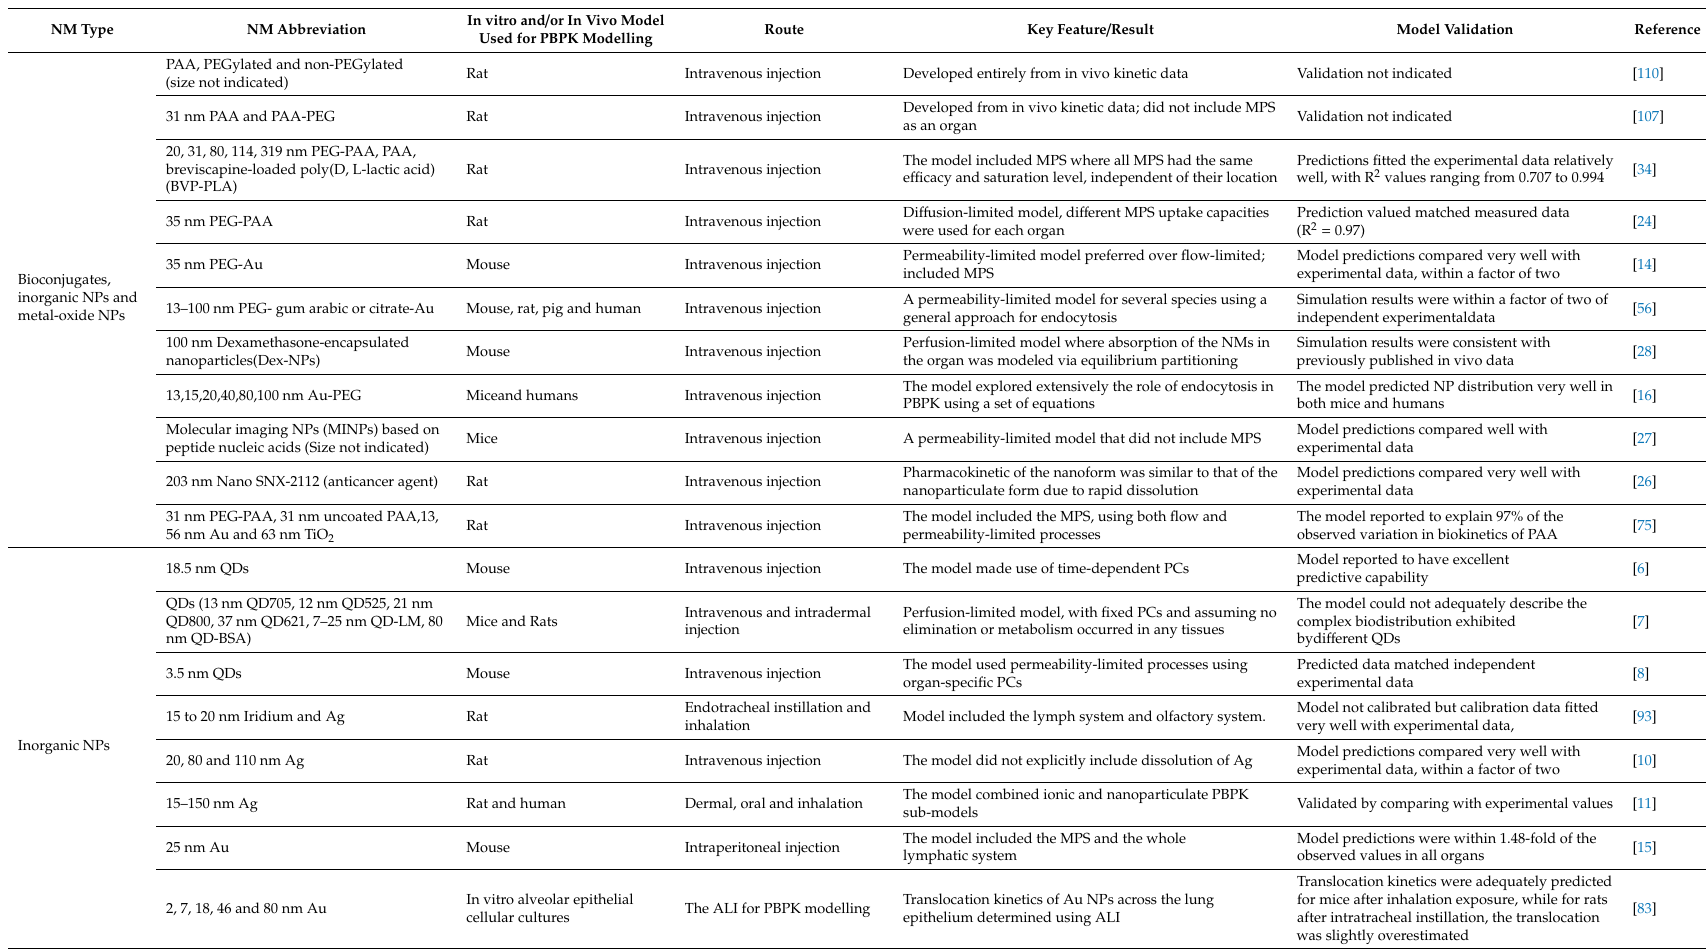
Table 1. Summary of existing physiologically based pharmacokinetic (PBPK) models for nanomaterials